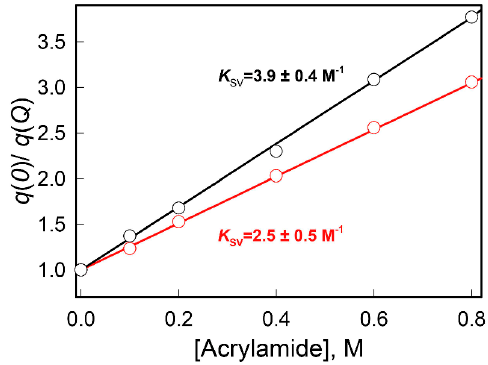
Figure 3. Acrylamide-induced quenching of intrinsic fluorescence of GGBP/H152C. Modified according Equation (12), Stern-Volmer dependences of the GGBP/H152C fluorescence intensity on acrylamide concentration in the solutions without denaturant (black curve) and in the presence of 0.1 M GdnHCl (red curve). The excitation wavelength was 297 nm.